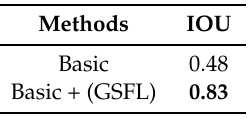
Table 7. Ground segmentation results with or without the GSFL